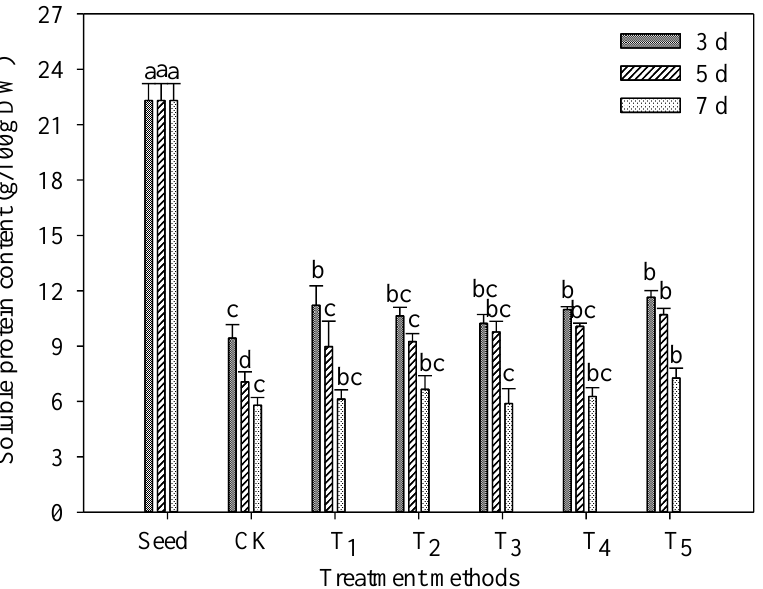
Figure 2. Effect of exogenous additives on the soluble protein content of TB sprouts. Different lowercase letters indicate significant statistical difference ( p < 0.05).